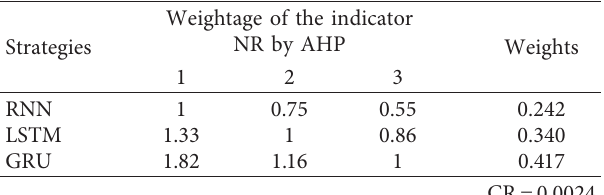
Table 8: Judgment matrix of the strategic layer relative to I Table 9: Judgment matrix of the strategic layer relative to I